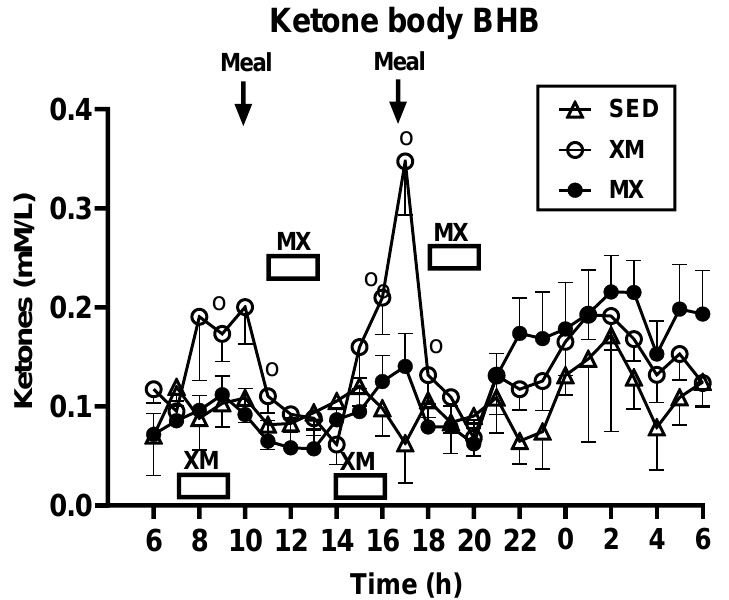
Figure 3. Exercise- and meal-timing effects on BHB concentrations. Circle superscripts identify time slices when group differences were significantly different. XM = exercise before meals, MX = exercise after meals, SED = sedentary group.